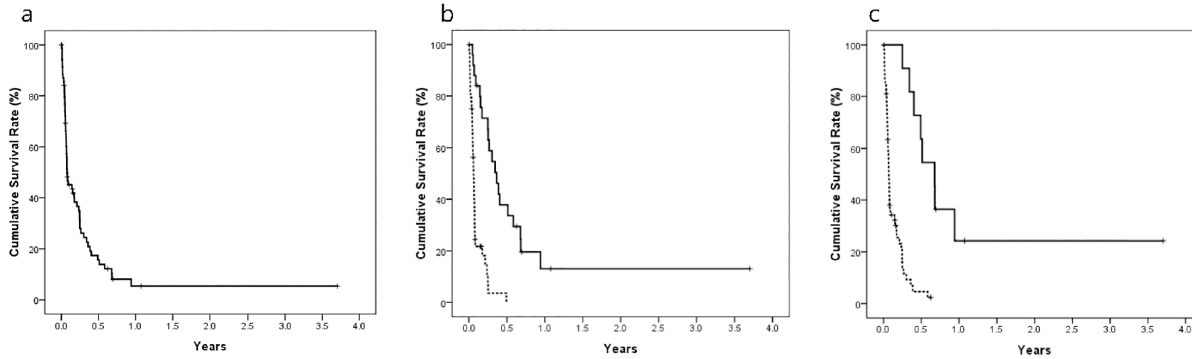
Fig 2. Cumulative survival rate of HCC patients who underwent biliary drainage. Cumulative survival rate in overallpopulation(A) and accordingto complete response after biliary drainage(B) and HCC treatment after biliary